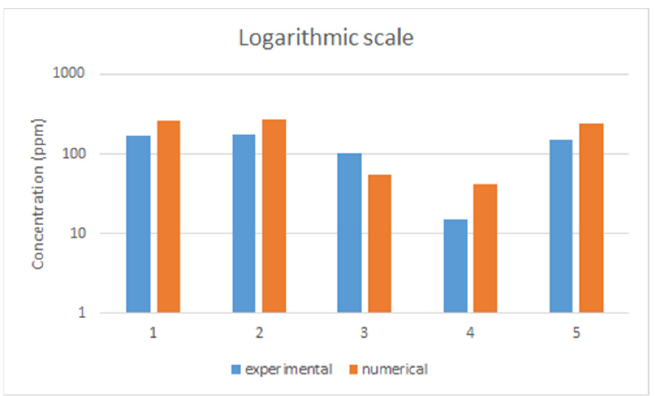
Figure 8. Comparison of results (experimental vs. numerically calculated).